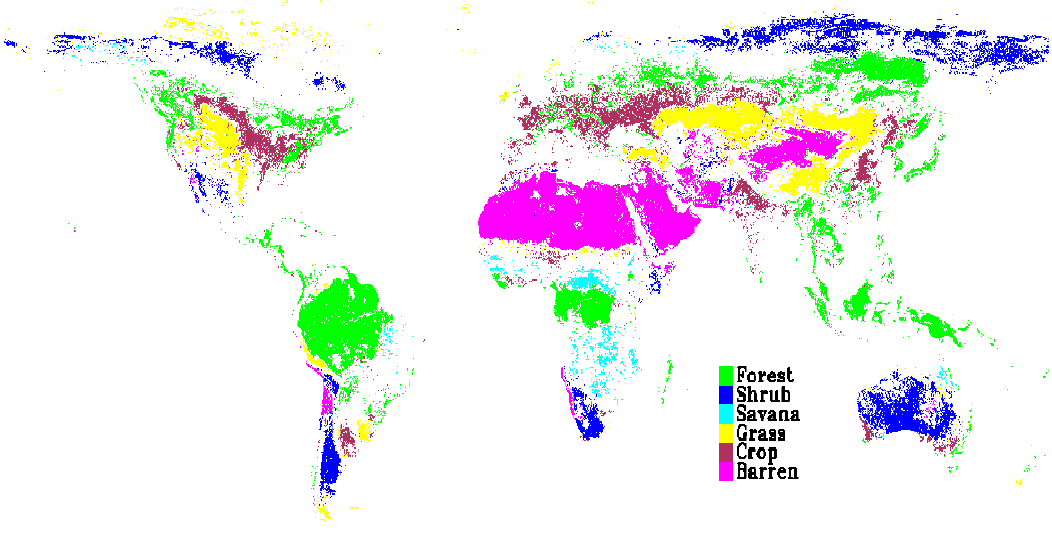
Figure 5. Global distribution of six land cover types composited from 2003 MODIS land cover